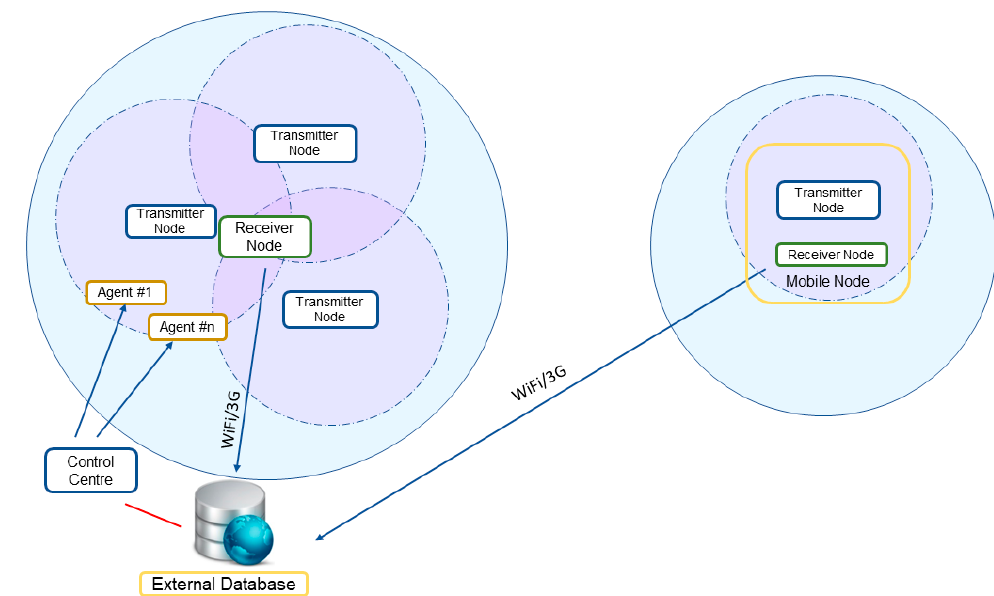
Figure 9. Integration of the Mobile node to create a Hybrid ‐ Wireless Sensor Network.